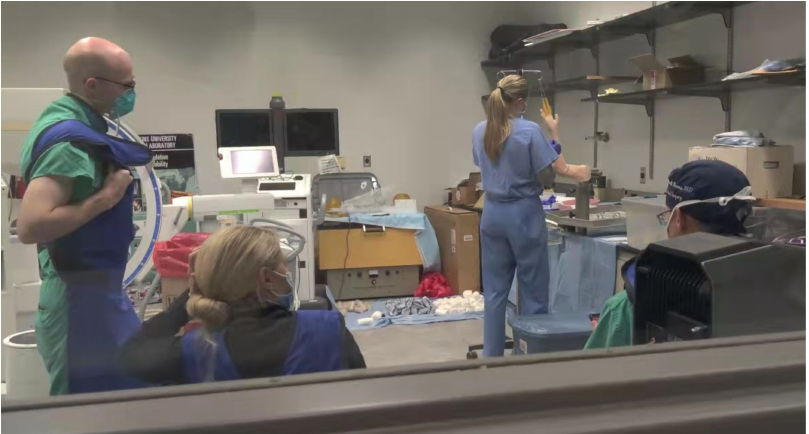
Figure 12. Photograph showing residency student, standing at middle right, practicing with the DRF phantom while under supervision of three